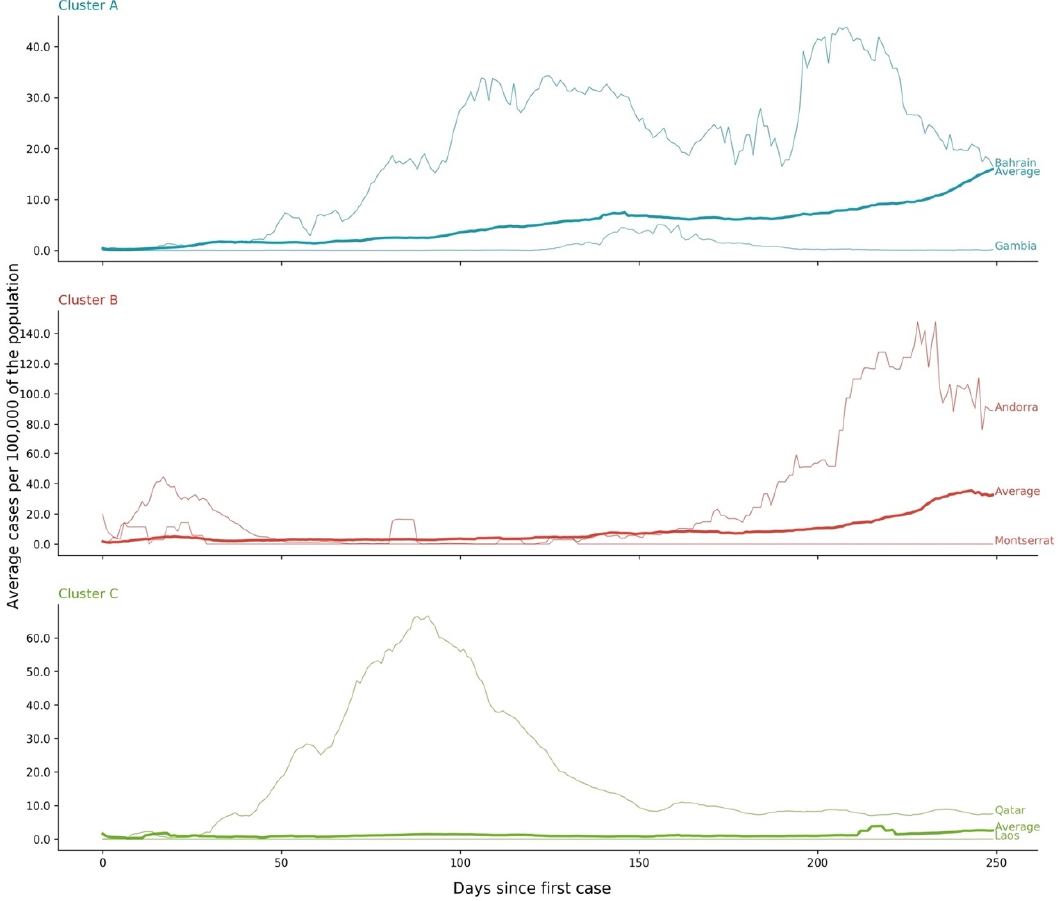
Figure 7. Seven days moving average of cases per 100,000 people in each cluster, with also time series of countries with minimum and maximum accumulated cases by 100,000 of the population at Day 250 in each of these clusters. Table 5. Averages and standard deviations (std) of variables per cluster of cases at Day 250 (* ex- cluding the 24 countries/territories that are not present in the UNDP dataset ).